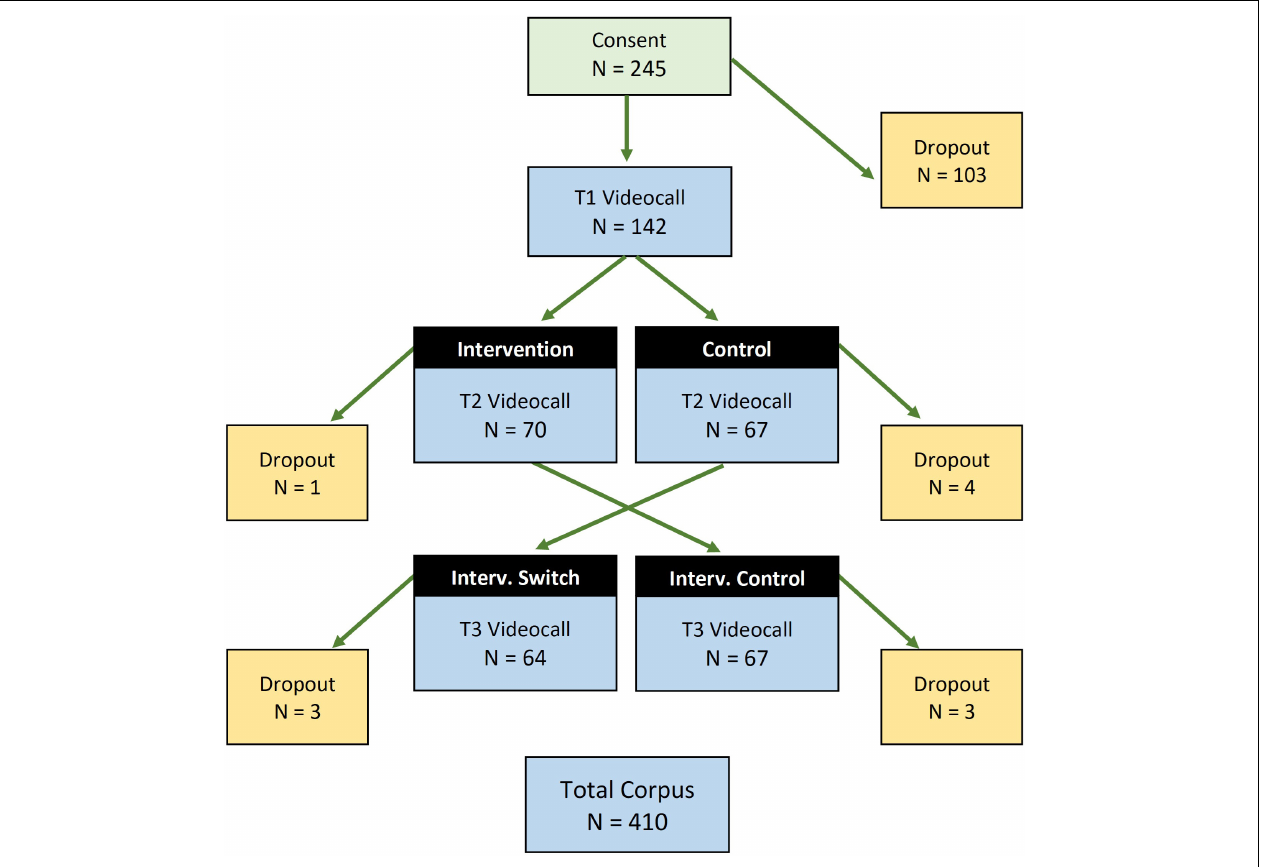
FIGURE 3 | Flowchart of participants and dropouts at different stages in the study. Total corpus N = 410 recorded parent-child interaction